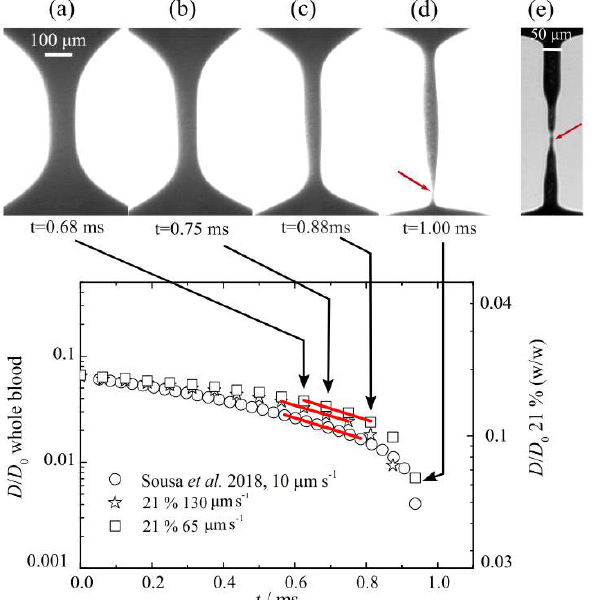
Figure 9. Time evolution of the filament thinning process of the particulate analogue fluid of 21 wt% Figure 5.6. Time evolution of the minimum filament diameter for two velocities, 65 and 130 µm/s, for the 21 % (w/w) PDMS suspension and for blood taken from Sousa et al. [30] PDMS microparticles suspension in an aqueous solution of 4 wt% SDS, in comparison with the (Htc = 40.3 %, donor D3). The lines represent the fits to determine the extensional relaxation time. The curves of the 21 % (w/w) PDMS solution were shifted in time. Sequence of images blood (circles) [52]. The red lines point out the linear fit to obtain the extensional relaxation time λ . showing the evolution of the filament, 130 µm/s, at the elastic-capillary regime, (a)-(c), Reproduced from Ref. [52] with permission from The Royal Society of filament before breaking (d) and Sousa, Vaz [30] filament before breaking, 10 µm s -1 , λ ~ 110 µs (e) are shown in the upper part of the figure .